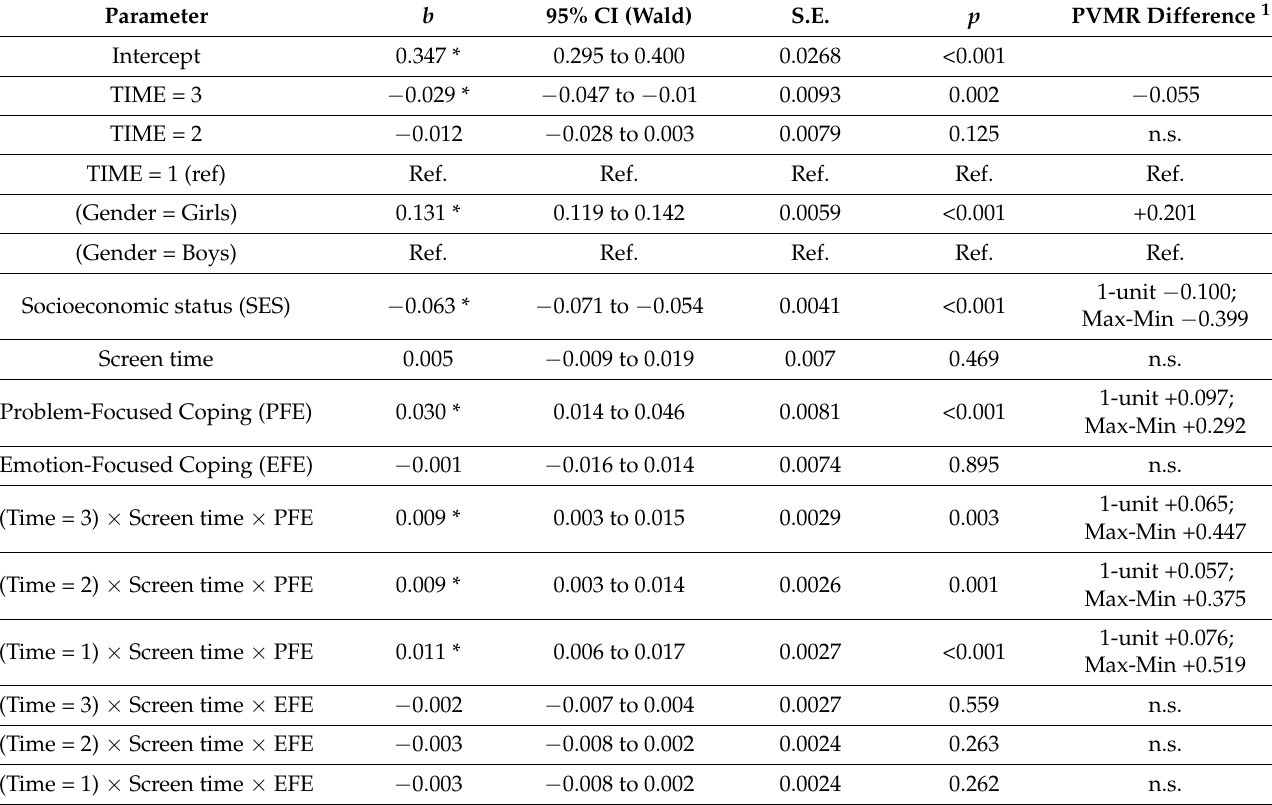
Table 1. Results of Generalized Estimating Equation (GEE) model, and the primary hypothesis test of time × screen time × coping interactions. The PFE and EFE coping scales are reversed (lower scores indicate more coping). Far right column shows the coefficient effect size in terms of predicted depression score (PVMR)